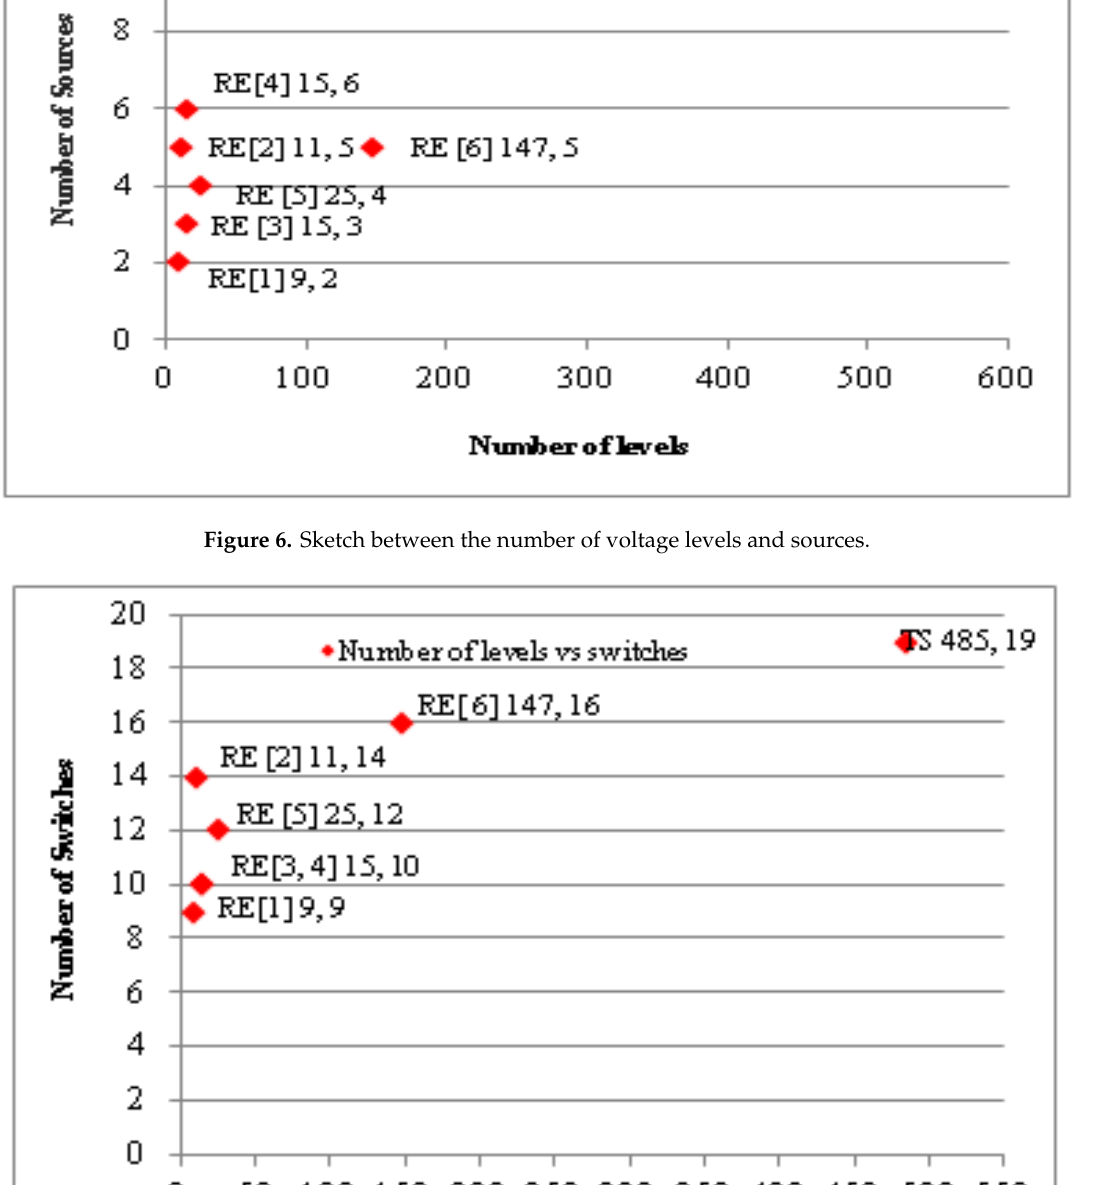
Figure 6. Sketch between the number of voltage levels and sources.